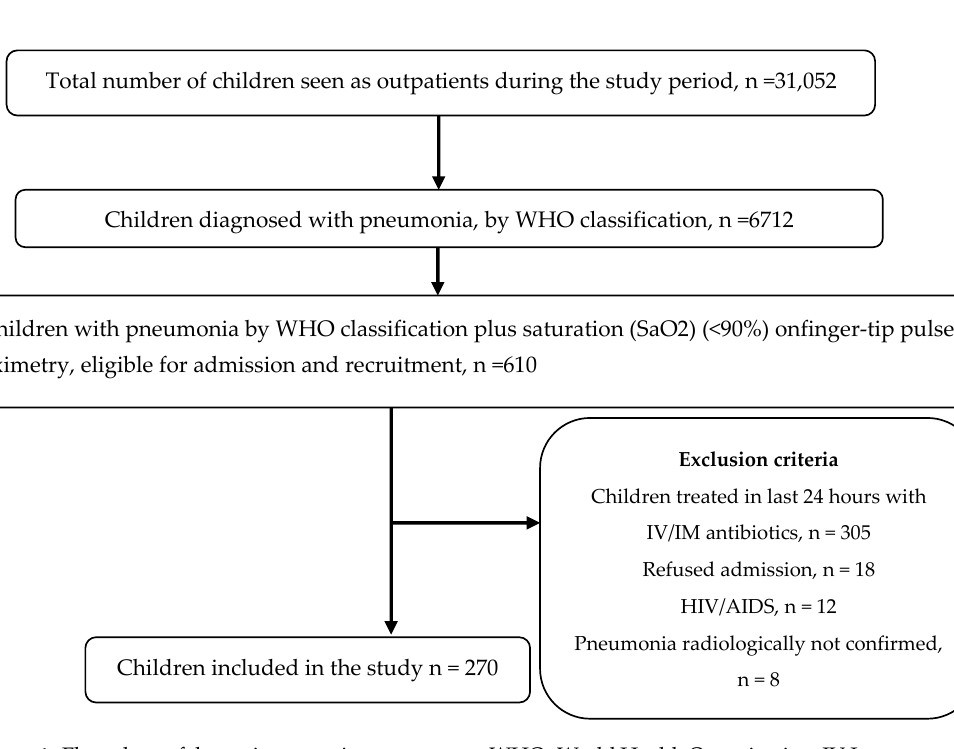
Figure 1. Flow chart of the patient recruitment process. WHO- World Health Organization, IV-Intravenous, IM-Intramuscular, HIV-Human Immunodeficiency Virus, AIDS-Acquired Immunodeficiency